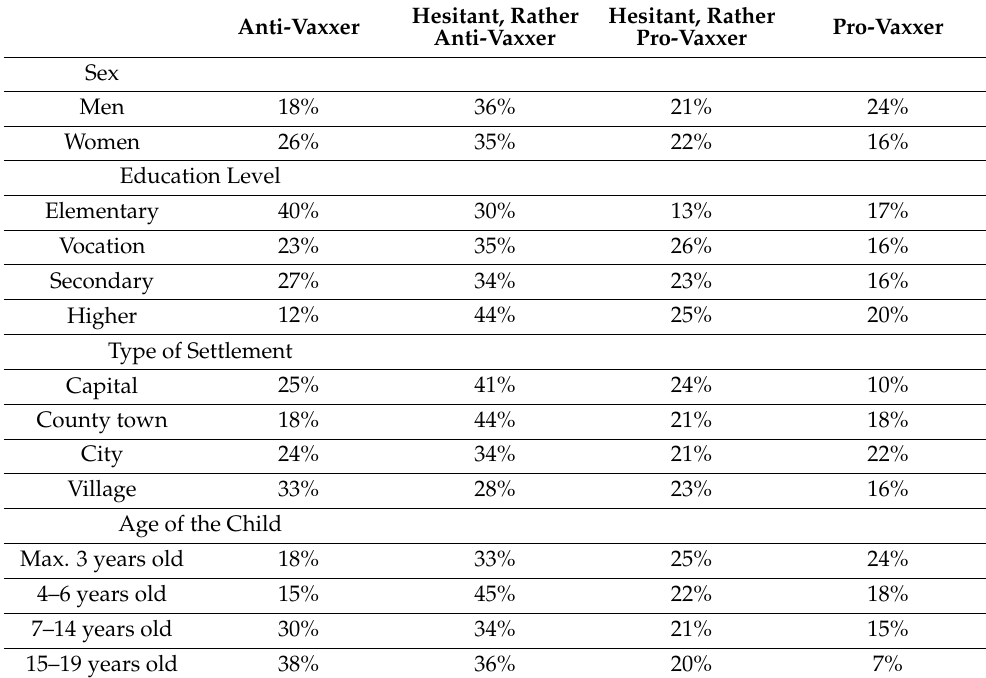
Table A5. Crosstabulation of the general attitudes towards vaccination with different socio- demographic dimensions. Row percentages.